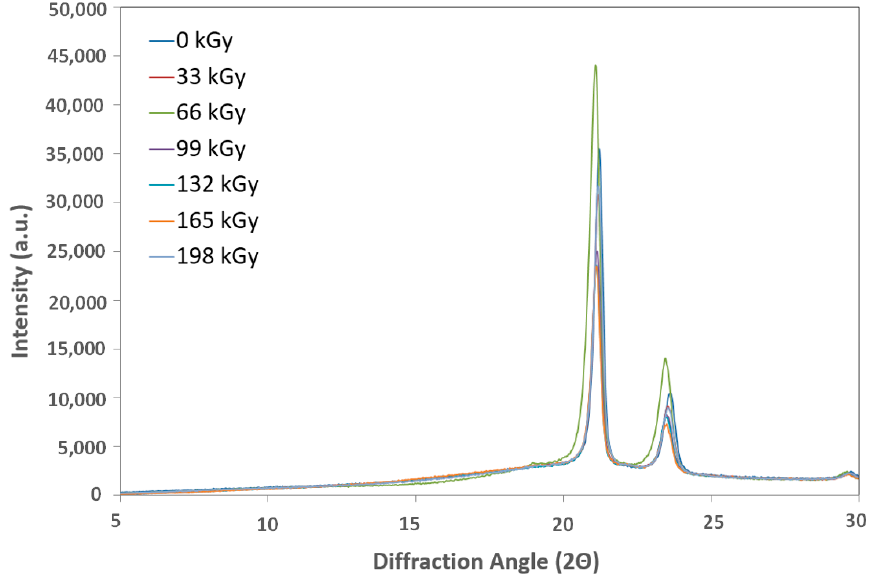
Figure 18. X-ray diffraction of irradiated HDPE. Figure 18. X-ray di ff raction of irradiated HDPE. Materials 2020 , 13 , x FOR PEER REVIEW